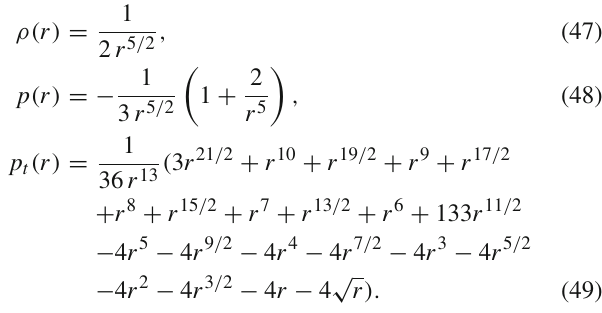
Fig. 7 The plot depicts the function r 1 ( n ,ω,α) as a function of ω and n for α = − 1 . It is clear that r 1 increases as α or n decreases. See the 2 text for details